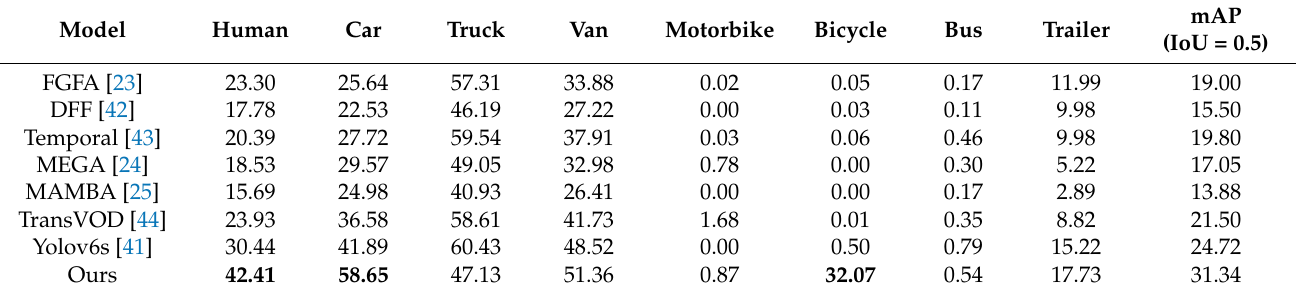
Table 7. Comparison results (average precision) to other object detection